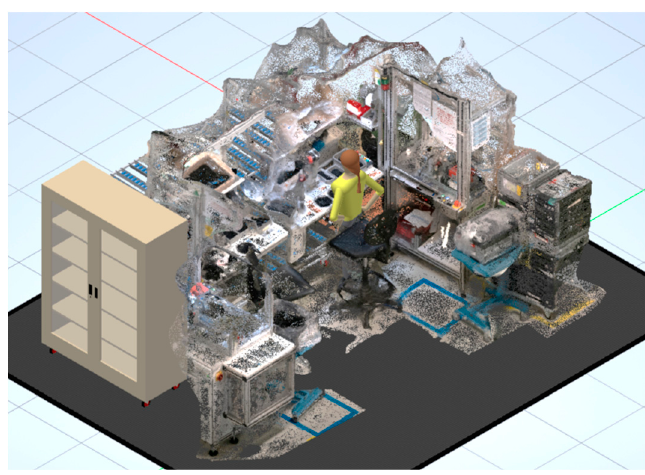
Figure 4. Three-dimensional model made from spherical camera data capturing.